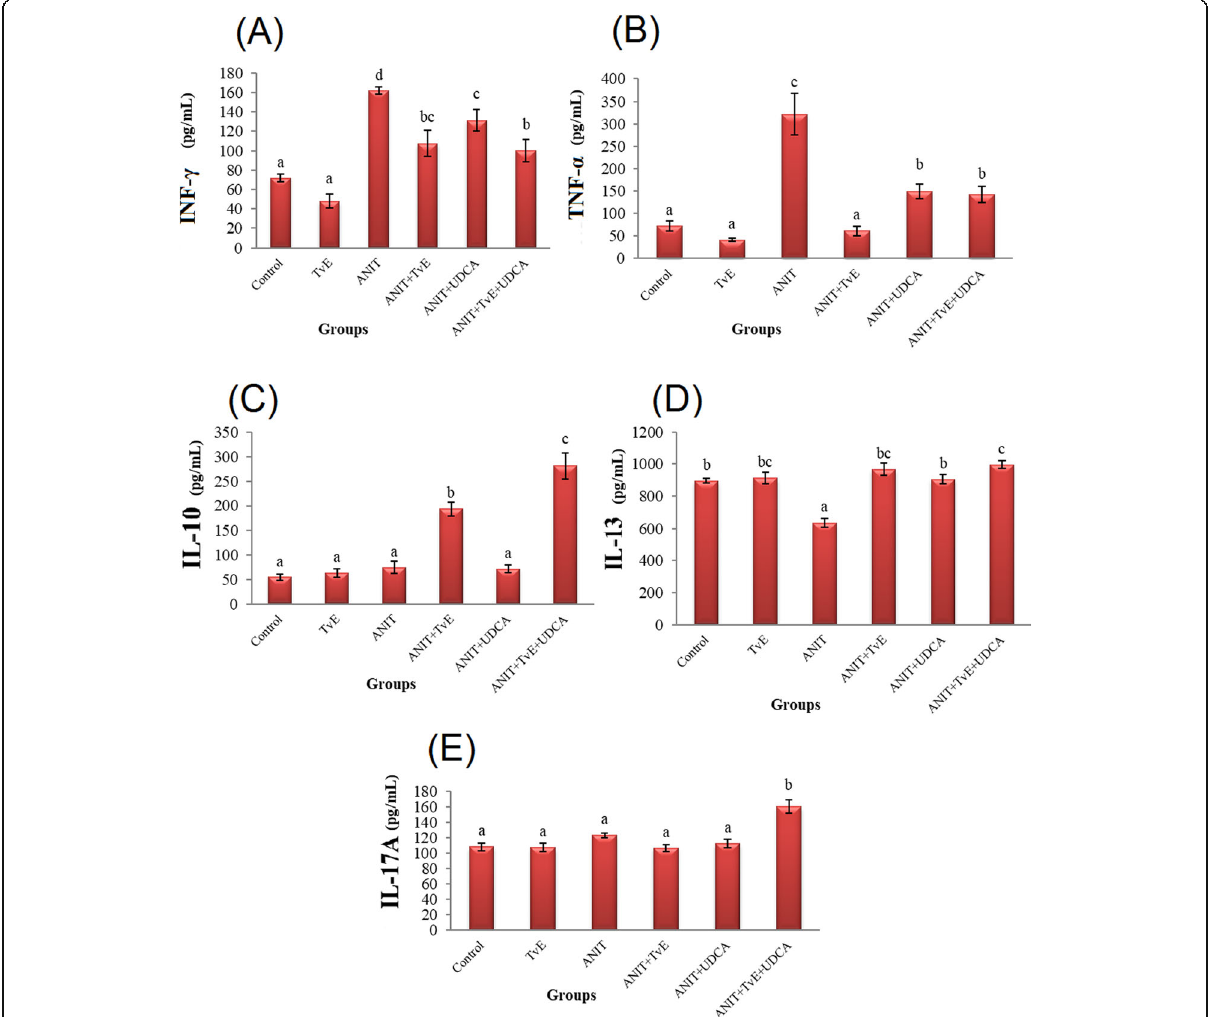
Fig. 1 Cytokines pattern of T helper (Th) cells. The serum levels of cytokine proteins were measured by ELISA in all studied rat groups; Th1-related cytokines, including a IFN- γ and b TNF- α ; Th2-related cytokines, including c Il-10 and d IL-13; Th17-related cytokines ( e ) IL-17. The data represented a mean of 6 rats ± standard error of mean (SEM). Values marked with the same superscript letters are similar insignificant ( P ≥ 0.05) whereas others are significant ( P <